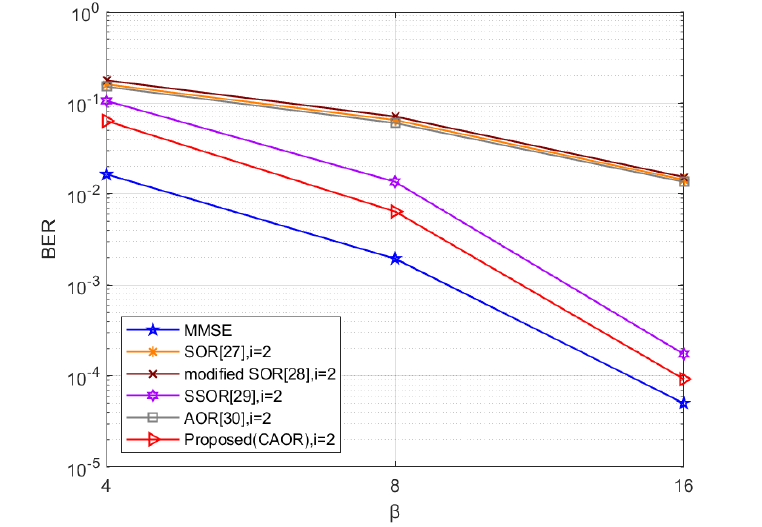
Figure 7. BER vs. β for different detection schemes when i = 2 and SNR is 40 dB.